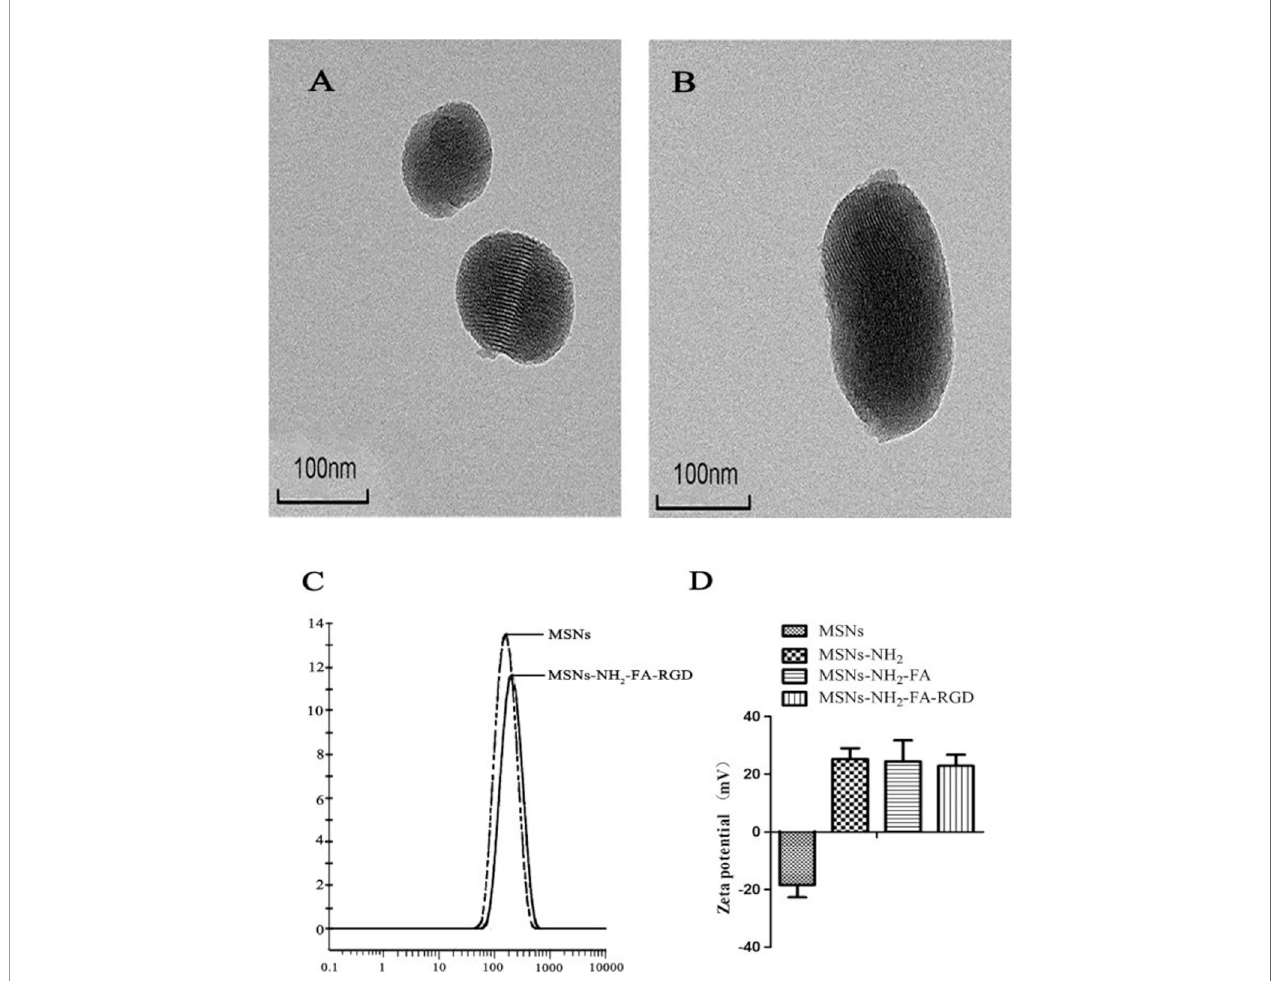
FIGURE 2 | TEM images of (A) MSNs and (B) MSNs-NH 2 -FA-RGD. (C) Particle size distribution of MSNs and MSNs-NH 2 -FA-RGD in deionized water. (D) Zeta potential of MSNs, MSNs-NH 2 , MSNs-NH 2 -FA, and MSNs-NH 2 -FA-RGD in deionized